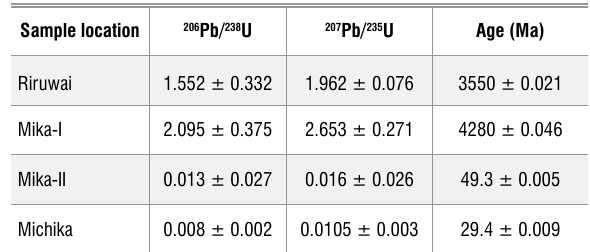
U-Pb isotopic ratio and average age of measured natural uranium samples